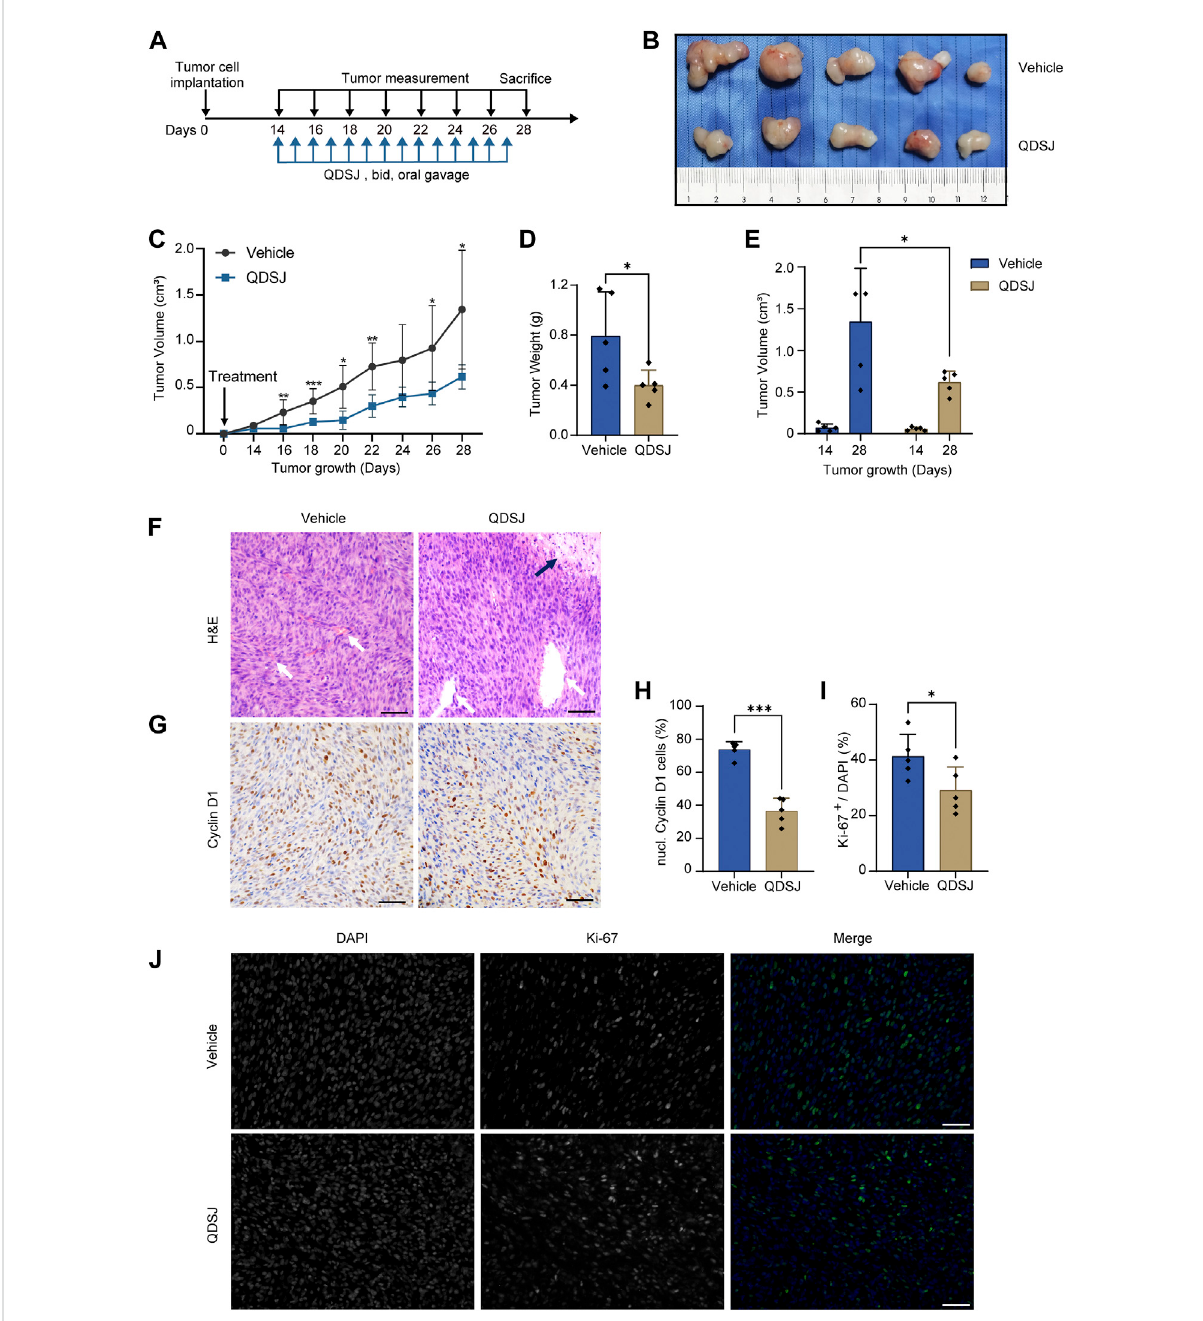
FIGURE 4 Treatment with QDSJ decoction suppresses schwannoma growth in vivo. (A) Outline of the experimental paradigm of BNI-VS-50 cell implantation and QDSJ treatment. QDSJ decoction was administered by oral gavage twice a day for 2 weeks. (B) Xenografts from the vehicle group and the QDSJ group. (C) Tumor growth curves of xenografts after BNI-VS-50 cell implantation and QDSJ treatment. Tumor sizes were measured every 2 days. A marked decrease in tumor size was observed 2 days after QDSJ treatment. (D) Tumor weight of the vehicle- and the QDSJ- treated groups 24 h after fi nal administration. (E) Tumor volume of the vehicle- and QDSJ-treated groups 14 days (before QDSJ treatment) and 28 days(after QDSJ treatment) after BNI-VS-50 implantation. (F) Representative images of H&E staining of the xenografts. Enlarged vascular vessels (white arrow) and a large area of cell necrosis were observed in QDSJ-treated tumors (black arrow). (G) Representative images of Cyclin D1 immunohistochemistry staining of the xenografts. (H) The fraction of Cyclin D1-positive nuclei in the vehicle- and QDSJ-treated groups. (I) The fraction of Ki-67-positive cells in the vehicle- and QDSJ-treated groups. (J) Representative images of Ki-67 immuno fl uorescence staining of xenograftsinQDSJ-andvehicle-treated tumors.Scalebar=100 μ m; n =5/group;means±SDs;* p < 0.05,** p < 0.01,and*** p < 0.001byStudent ’ s t